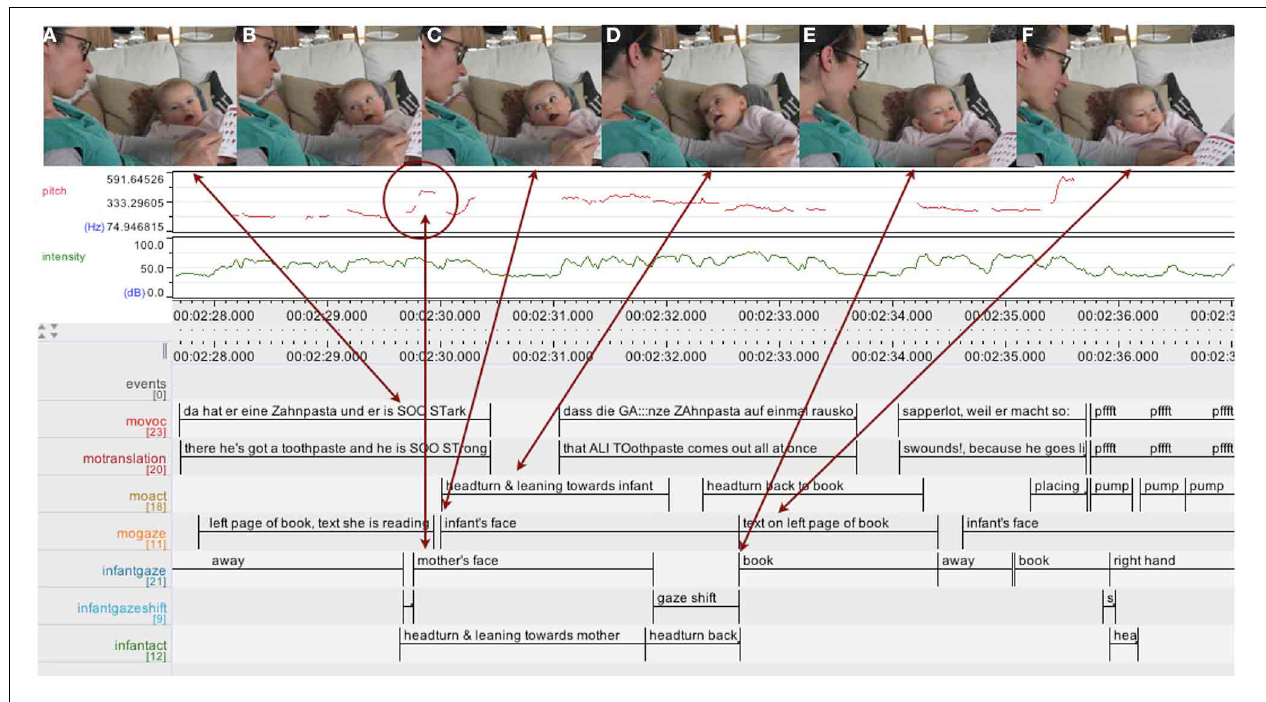
conjunction with salient vocal event at (B) . Affective communicative exchange with mutual reinforcement (C,D) . The infant’s gaze spontaneously returns the book (E) , before mother’s gaze returns there as well (F)